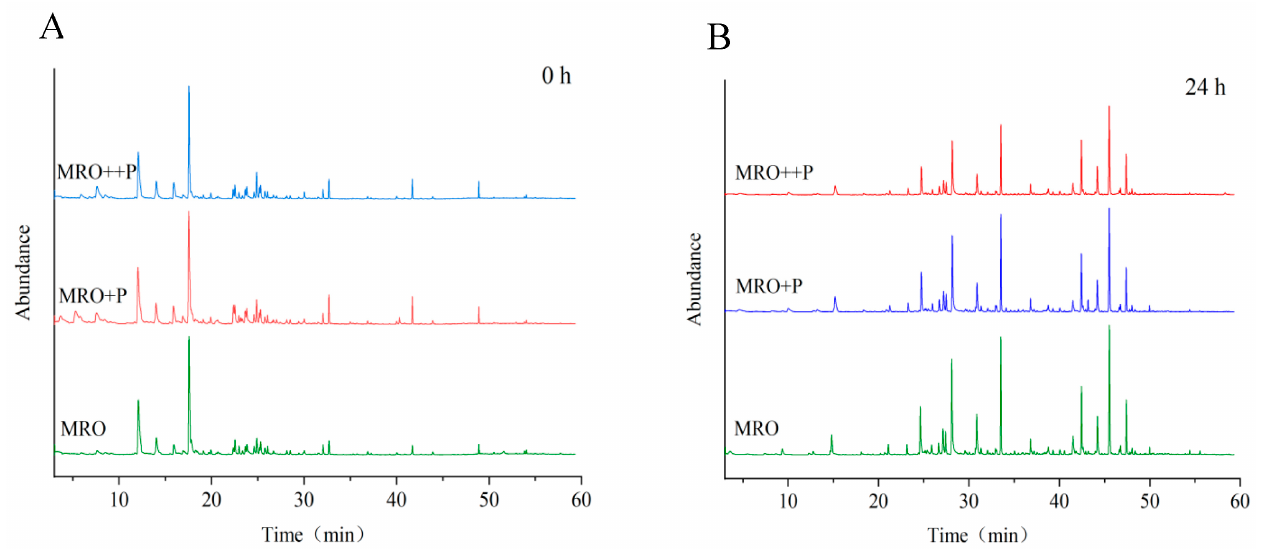
Figure 2. Chromatograms of the flavor compounds extracted by SPME from the oil samples frying for 0 h ( A ) and 24 h ( B ).